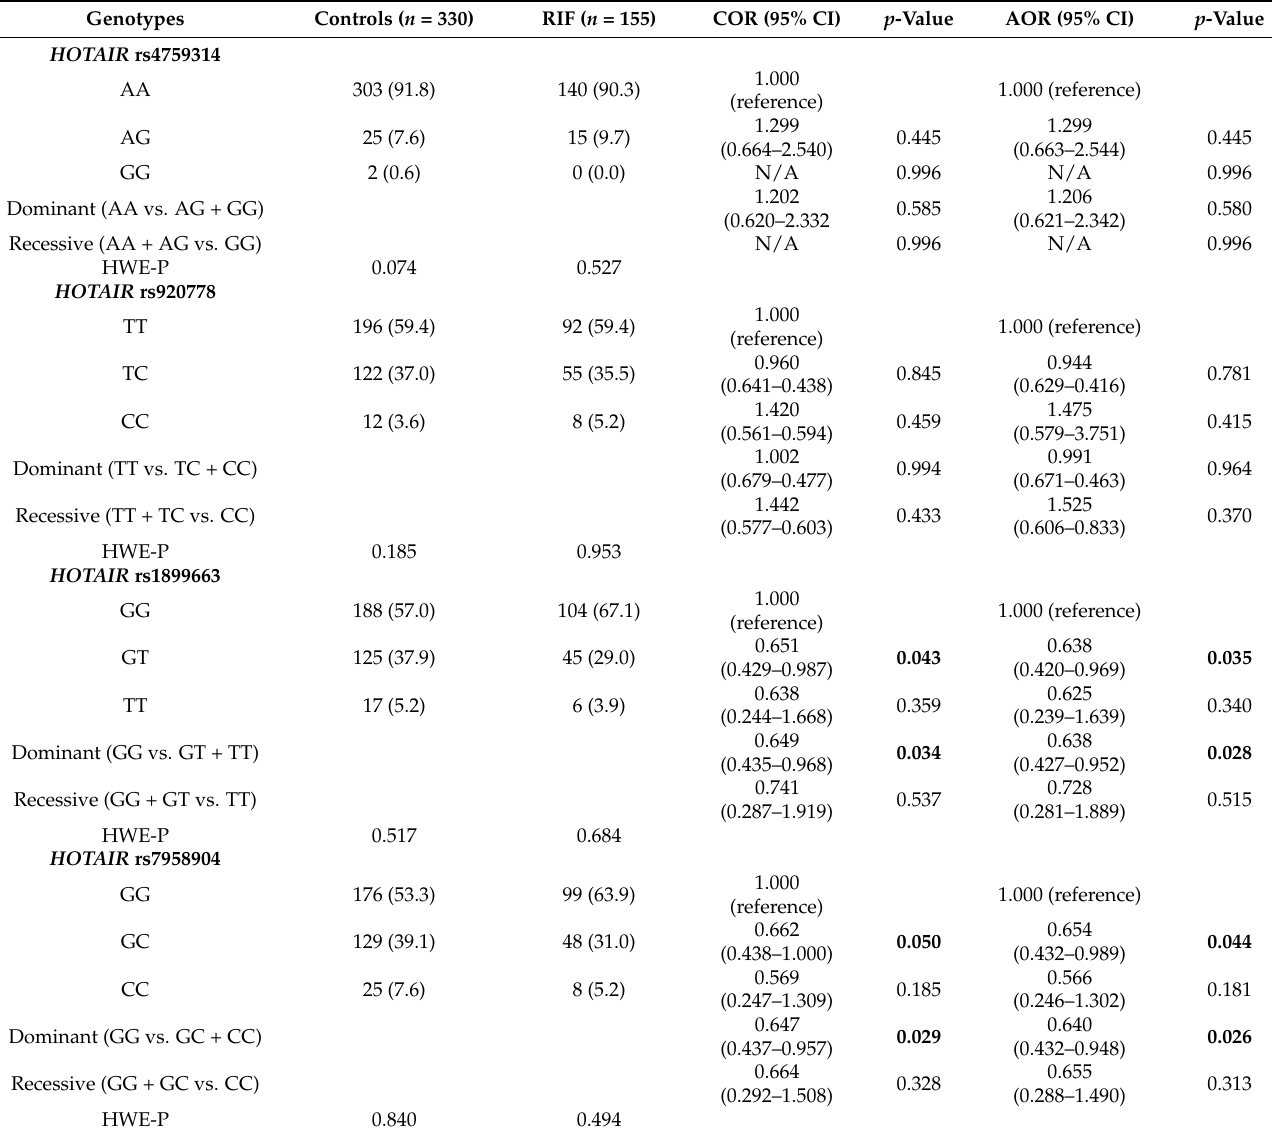
Table 2. Comparison of genotype frequencies and AOR values for polymorphisms between RIF patients and control